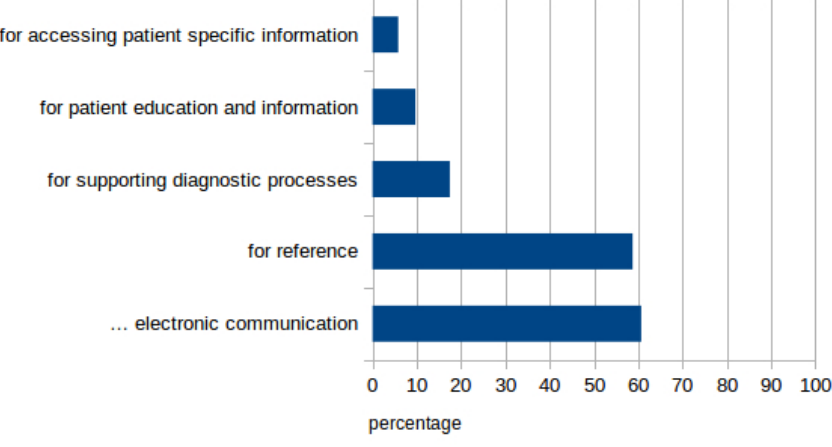
Figure 1. Activities the mobile devices were used for by the participating physicians.